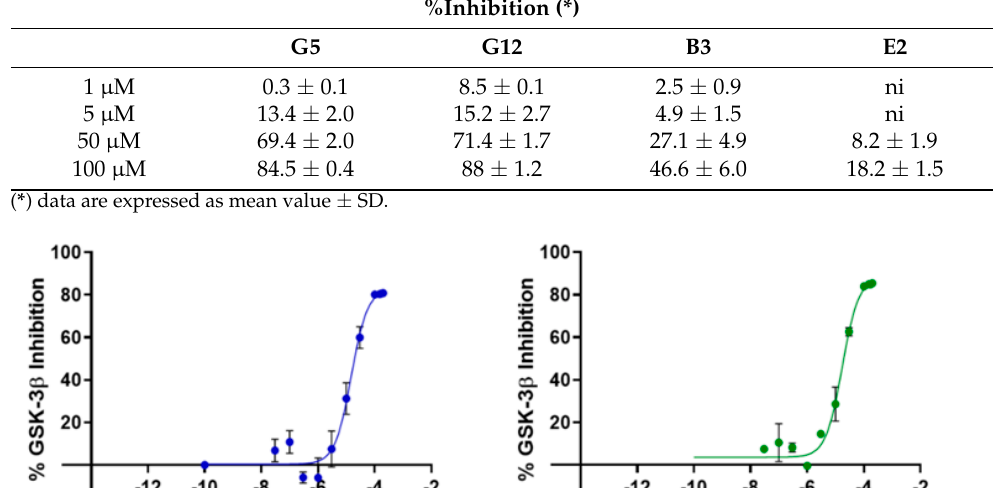
Table 1. %inhibition of GSK-3 β obtained for G5, G12, B3 and E2. %Inhibition (*)